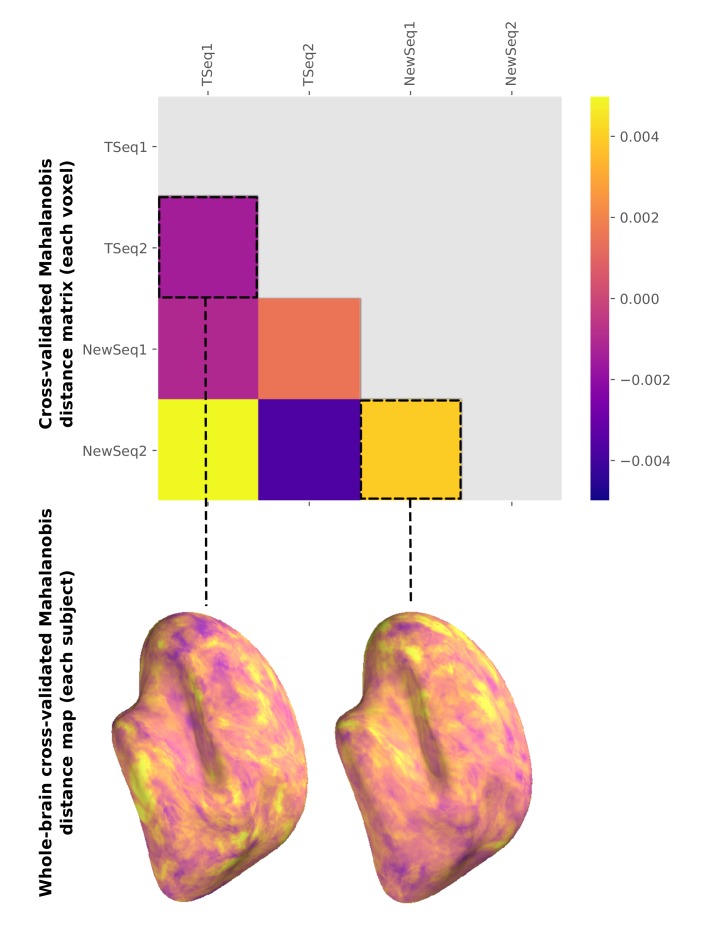
Illustration of the method: for each neighborhood centered on a gray-matter coordinate, we computed cross-validated Mahalanobis distance matrices.The two maps of interest, respectively representing the distances between new sequences and between consolidated sequences, were then analyzed at the group level.